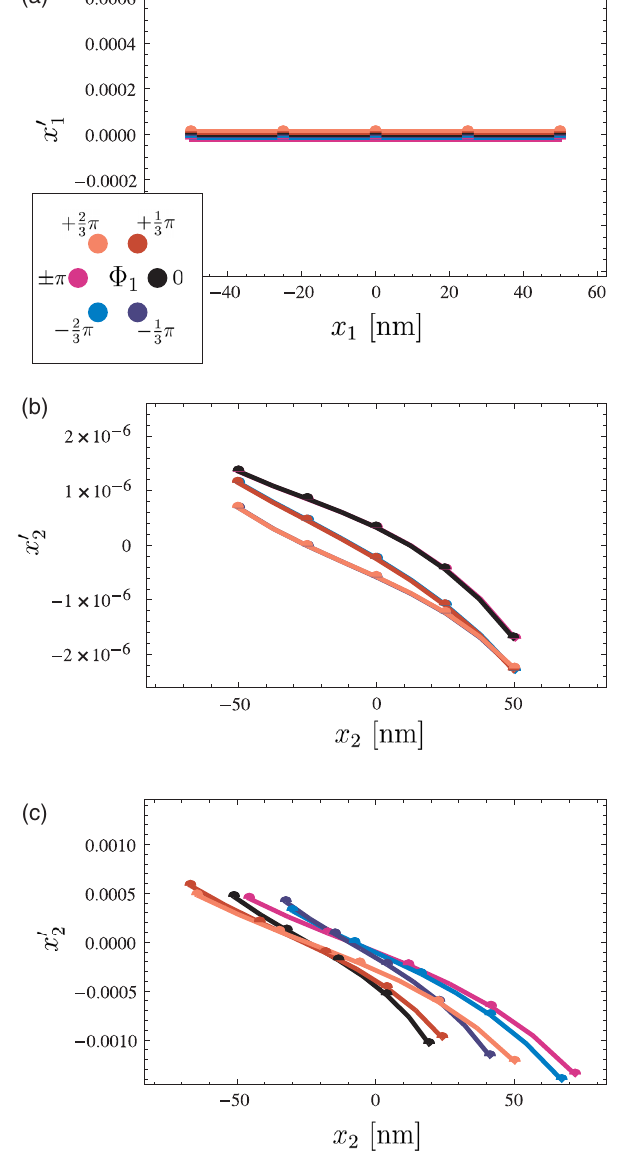
FIG. 7. The focusing properties of the accelerator segment shown in Fig. 6, calculated for the unit cell shown in Fig. 3 using Eq. (A1). (a) Assumed ð x 1 ; x 0 1 Þ at the entrance of the segment: a parallel beam. (b) Calculated ð x 2 ; x 0 2 Þ at the exit of the segment, for n ¼ 1 and m ¼ 0 . (c) Calculated ð x 2 ; x 0 2 Þ at the exit of the segment, for n ¼ 8 and m ¼ 5